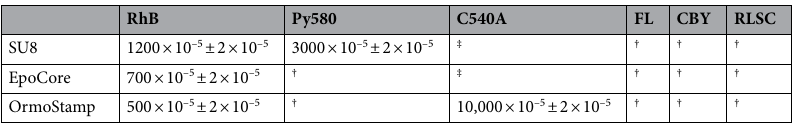
Table 1. Maximum dye concentrations (M), limited by solubility and polymerization inhibition. † Limited by solubility. ‡ limited by polymerization inhibition.